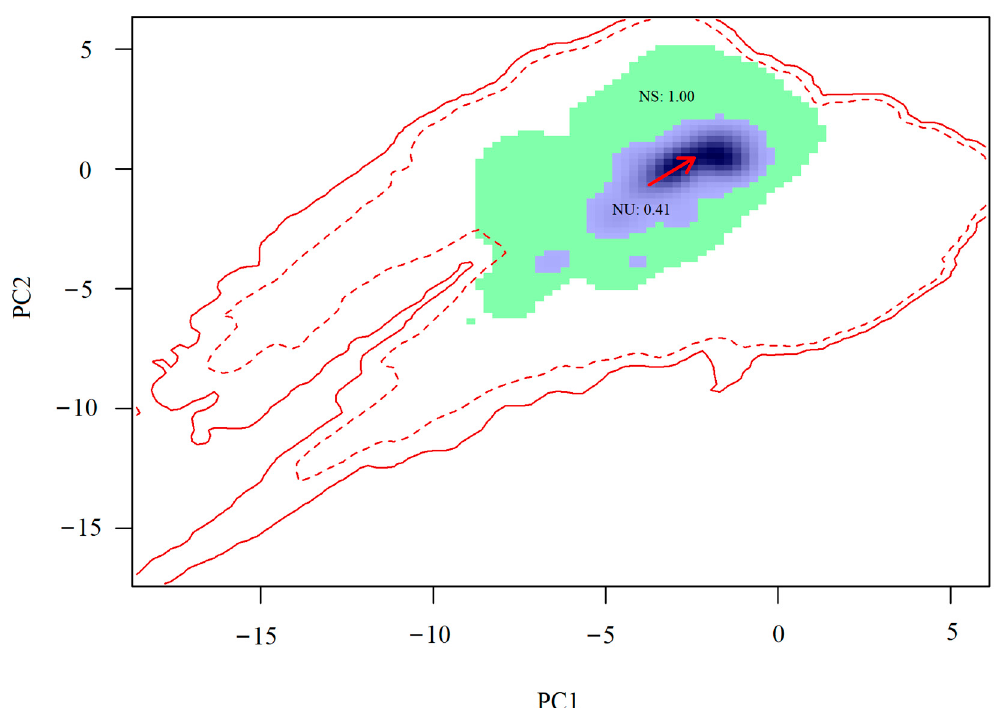
Figure 4. Niche shifts between the fall webworm in Europe and the fall webworm in North America. The green and blue colors indicate niche stability and unfilling niche, respectively, which were 1.00 and 0.41, respectively. Red arrow represents the direction of niche shifts. Solid and dotted contour lines in red indicate climatic conditions of the fall webworm in North America and Europe, respectively.